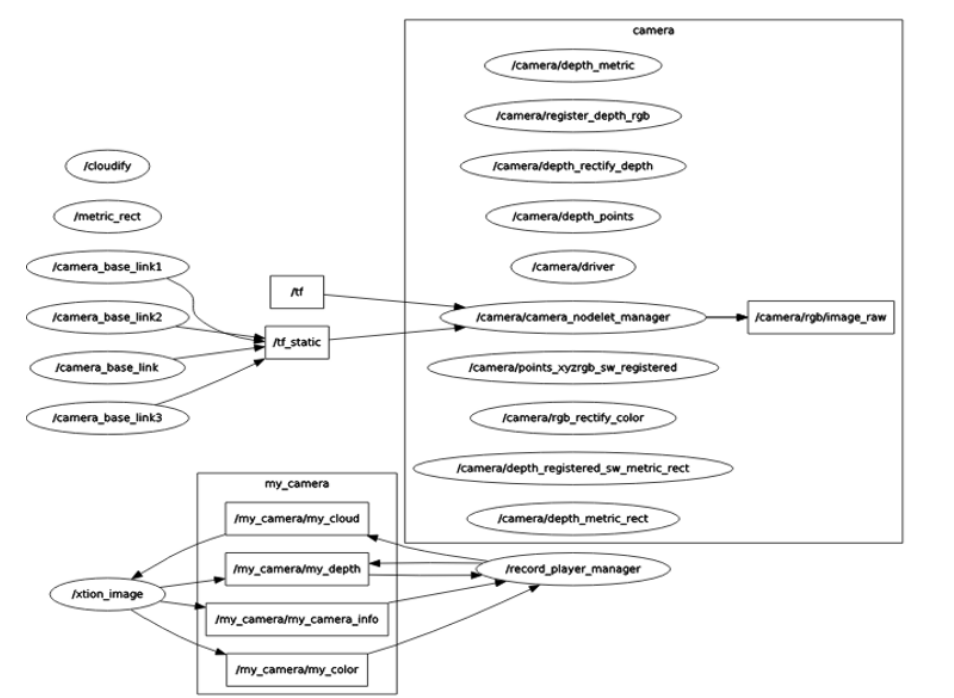
Fig. 3. The graph of dependencies between ROS nodes.